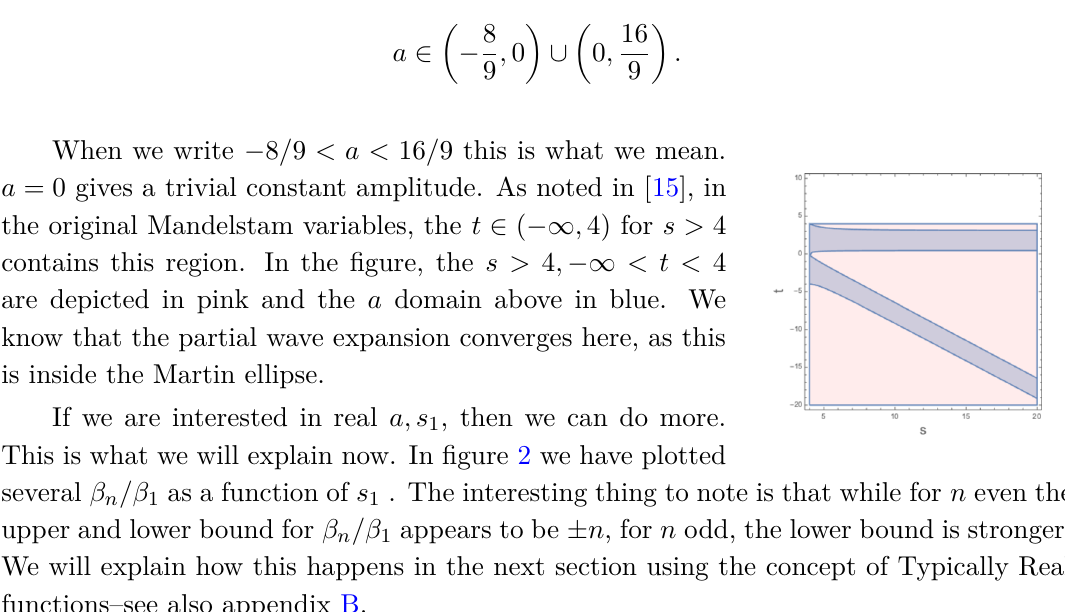
) 2 (1 − a/s ) − 2 | < 2 . The 1 1